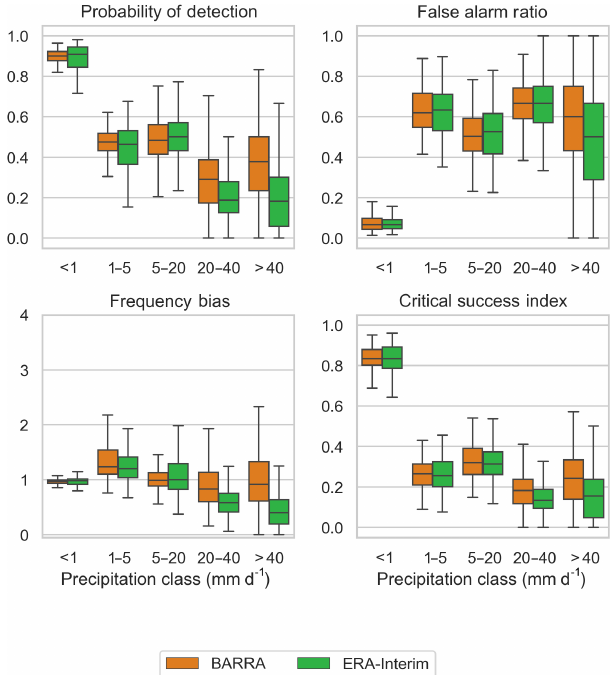
Figure 10. Boxplot of categorical performance indices (probability of detection, false alarm ratio, frequency bias, and critical success index) calculated against AWAP data for five classes of rainfall in- tensity. Each box extends from first to third quartile, medians are marked in each box, and whisker extends to furthest point or 1.5 times the interquartile range, whichever is